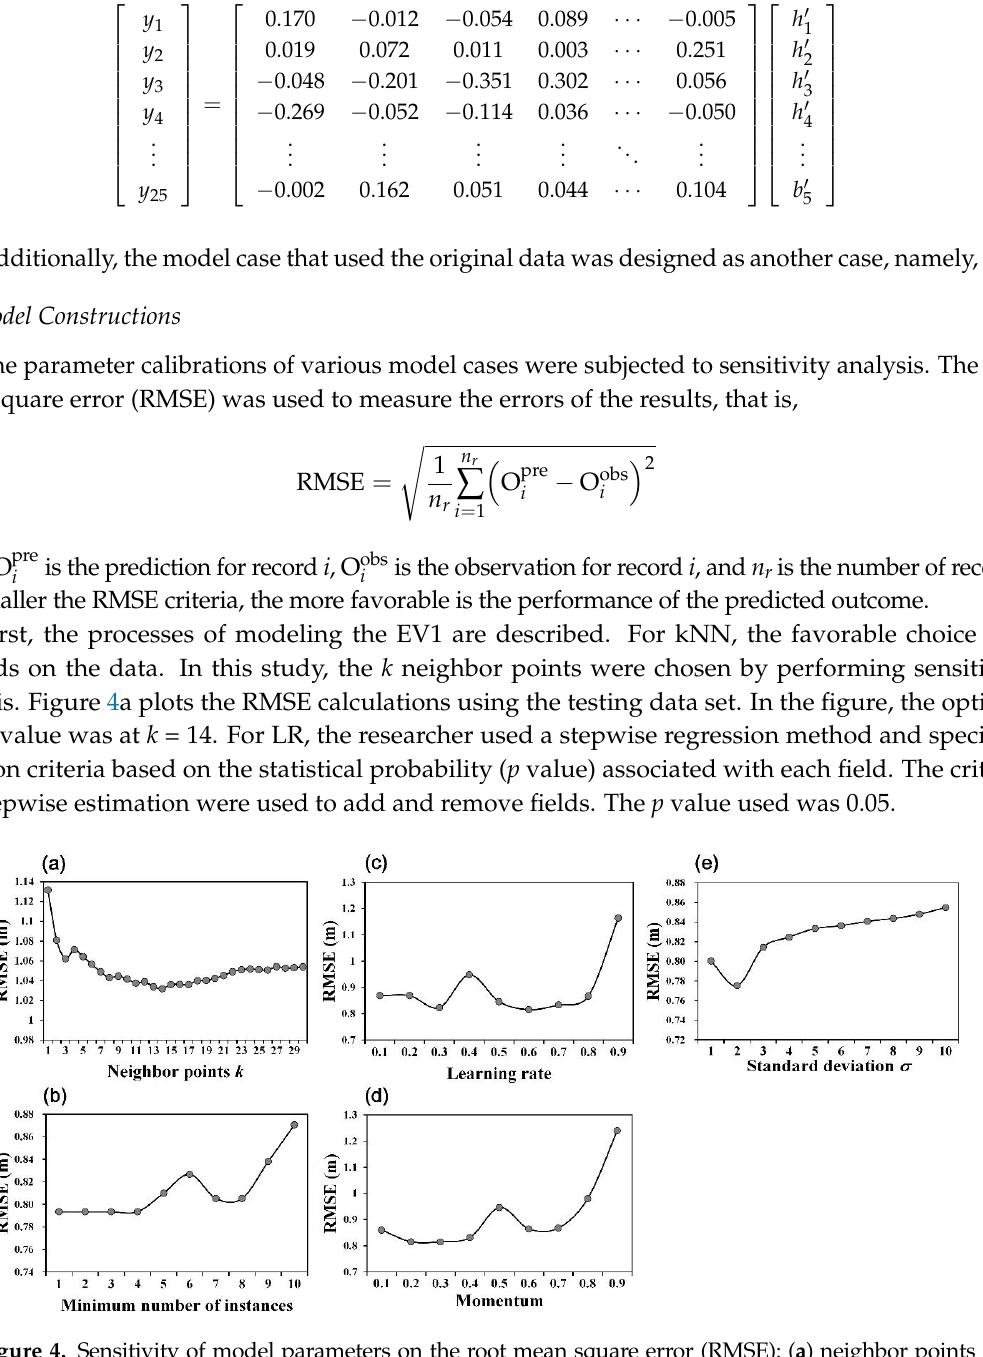
Figure 4. Sensitivity of model parameters on the root mean square error (RMSE): ( a ) neighbor points for k-nearest neighbors (kNN), ( b ) minimum number of instances for M5, ( c ) learning rate for multilayer perceptron (MLP), ( d ) momentum for MLP, and ( e ) standard deviation for support vector regression (SVR).